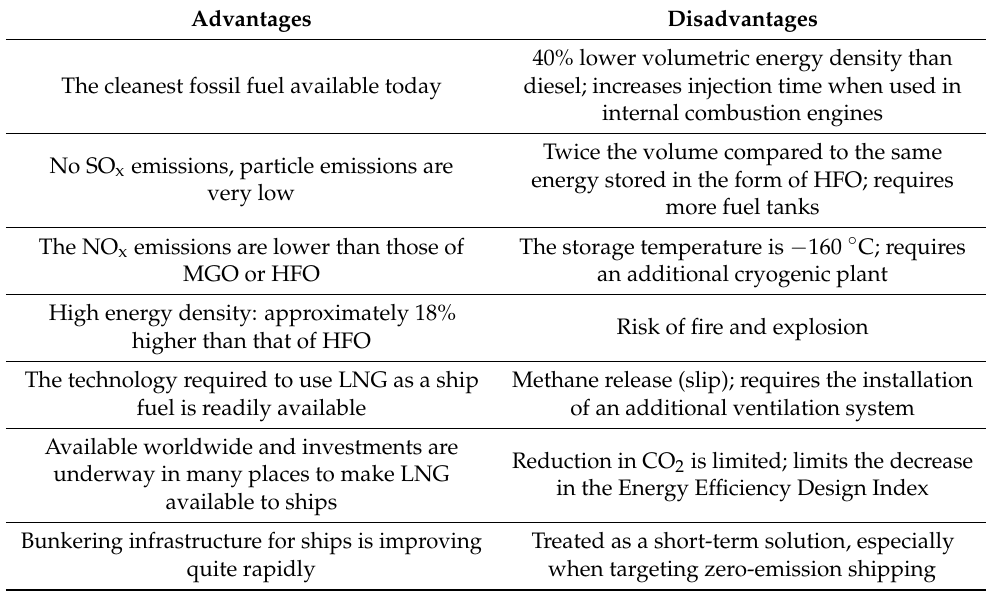
Table 2. An overview of the advantages and disadvantages of LNG as an alternative fuel for the shipping sector